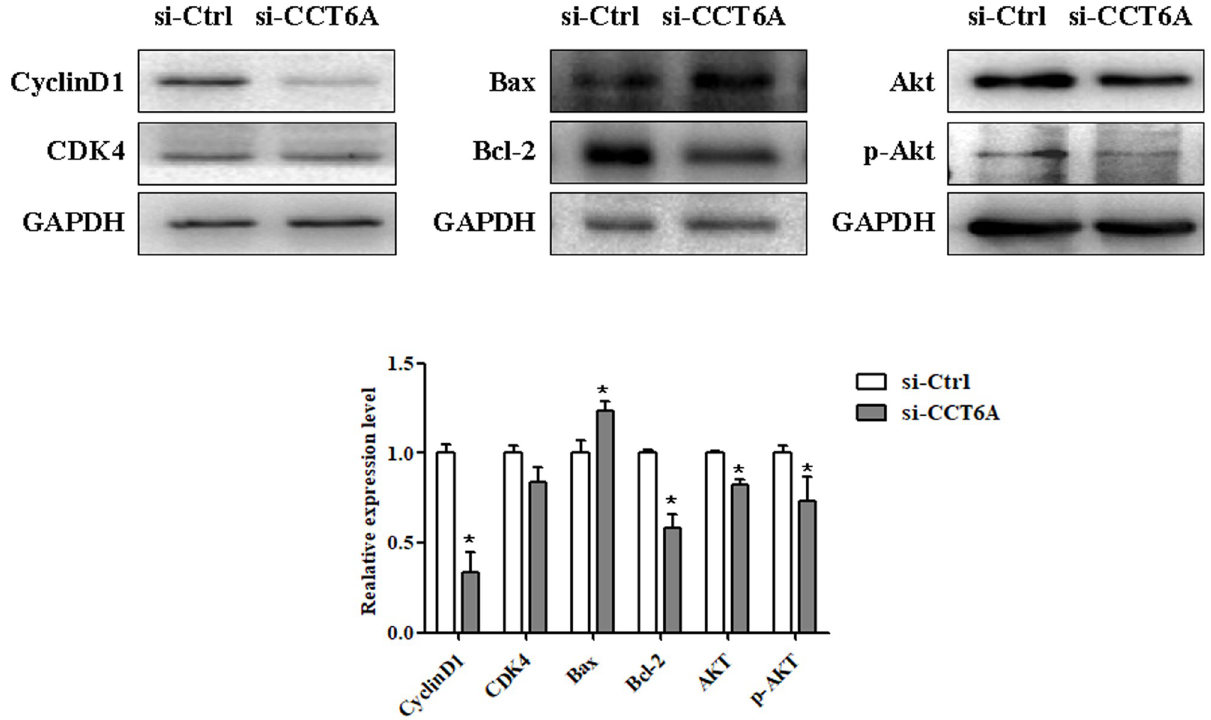
Fig 6. The effect of CCT6A on activation pathways and its downstream expression in U-2 osteosarcoma cells. After transfection with si-Ctrl or si- CCT6A-3 for 72 h, the protein expression of p-Akt, Akt, Bax, Bcl-2, cyclinD1, and CDK4 were determined by Western blot analysis. Representative images are shown in the upper panel and the quantification of their expression using ImageLab software is shown in the lower panel. GAPDH was used as an internal control. � p < 0.05 vs. si-Ctrl. Akt, protein kinase B; Bax, Bcl-2-associated X-protein; Bcl-2, B-cell lymphoma-2; CCT6A, chaperonin- containing TCP1 subunit 6A; CDK4, cyclin-dependent kinase 4; GAPDH, glyceraldehyde 3-phosphate dehydrogenase; p-Akt, phospho-protein kinase B; si-CCT6A, chaperonin-containing TCP1 subunit 6A; si-Ctrl, control small interfering ribonucleic acid; siRNA, small interfering ribonucleic acid.